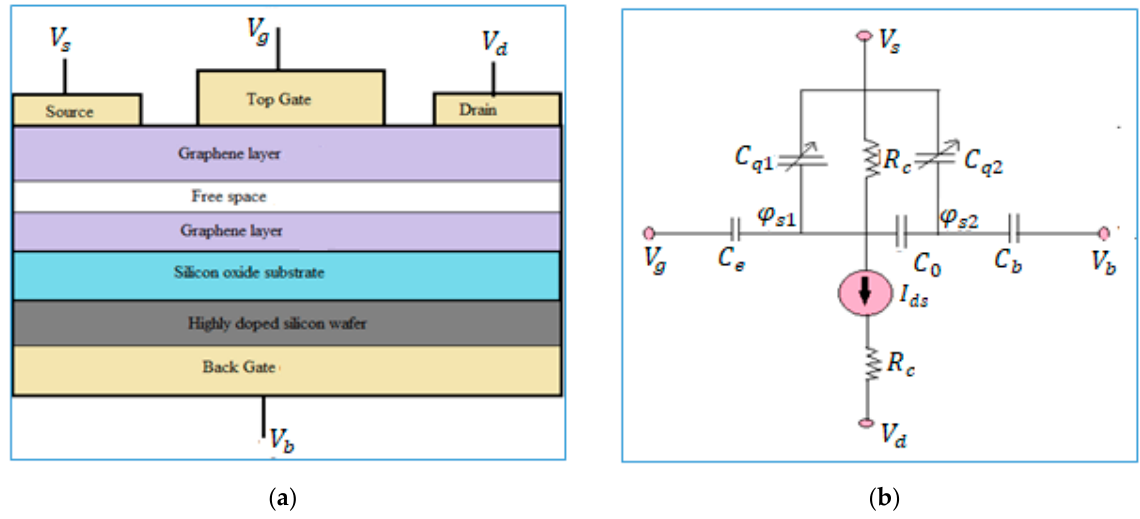
Figure 2. Schematic demonstration of bilayer graphene field effect transistor. ( a ) Bilayer transistor layout, ( b ) equivalent model.